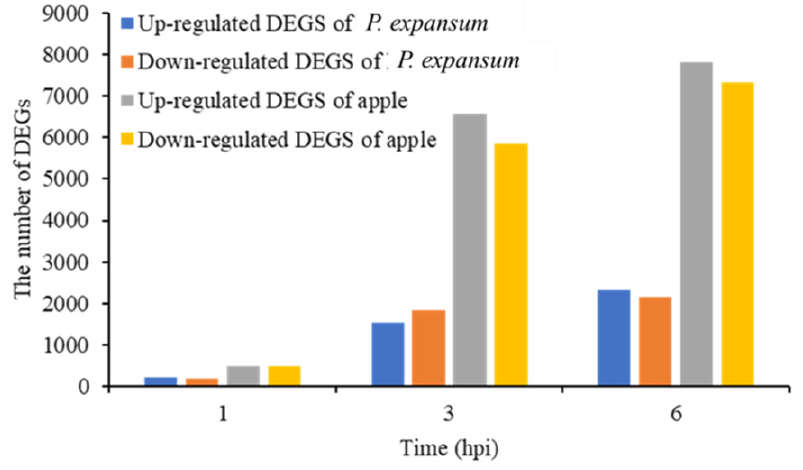
Figure 2. The total number of up- and down-regulated P. expansum and apple differentially expressed genes (DEGs) at 1 h post-inoculation (hpi), 3 hpi, and 6 hpi.